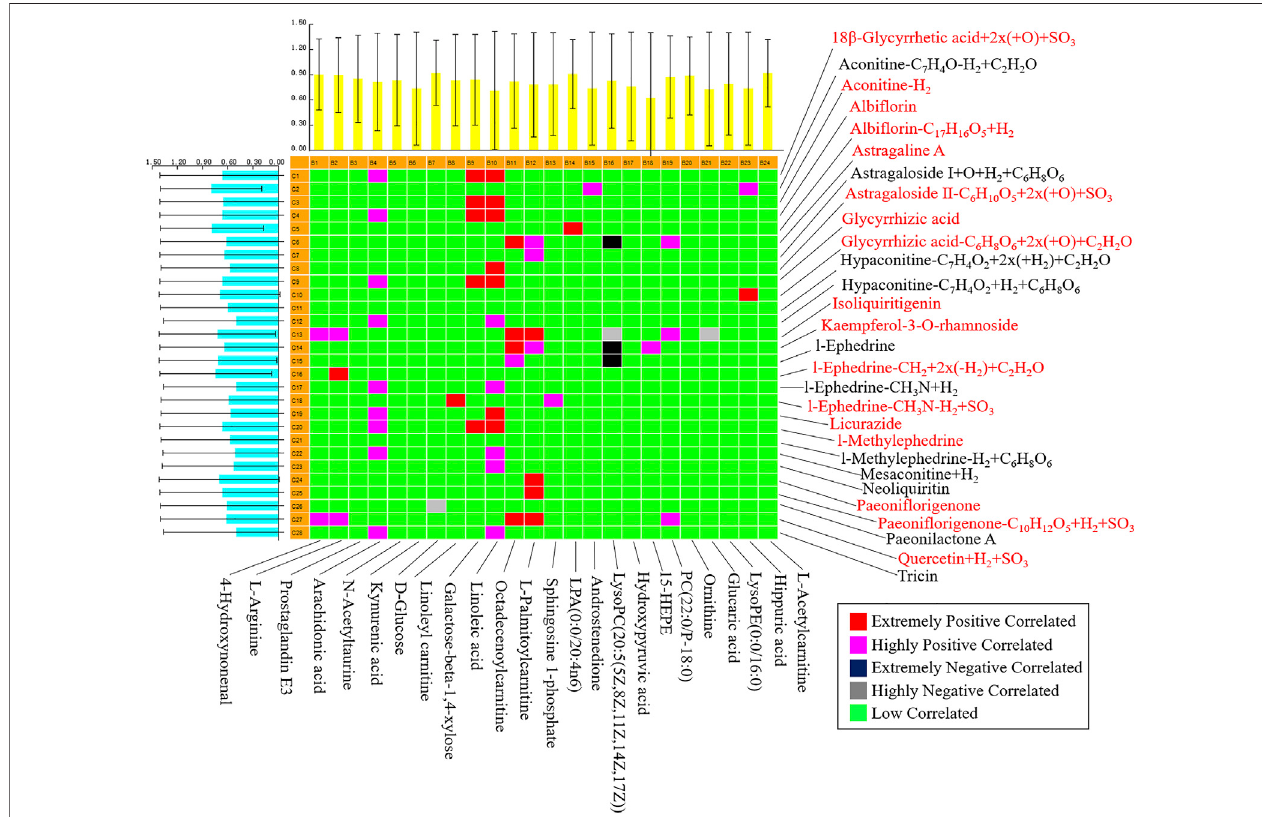
FIGURE 8 | Pearson correlation analysis of blood components of wutou decoction and potential biomarkers in adjuvant-induced arthritis rat.